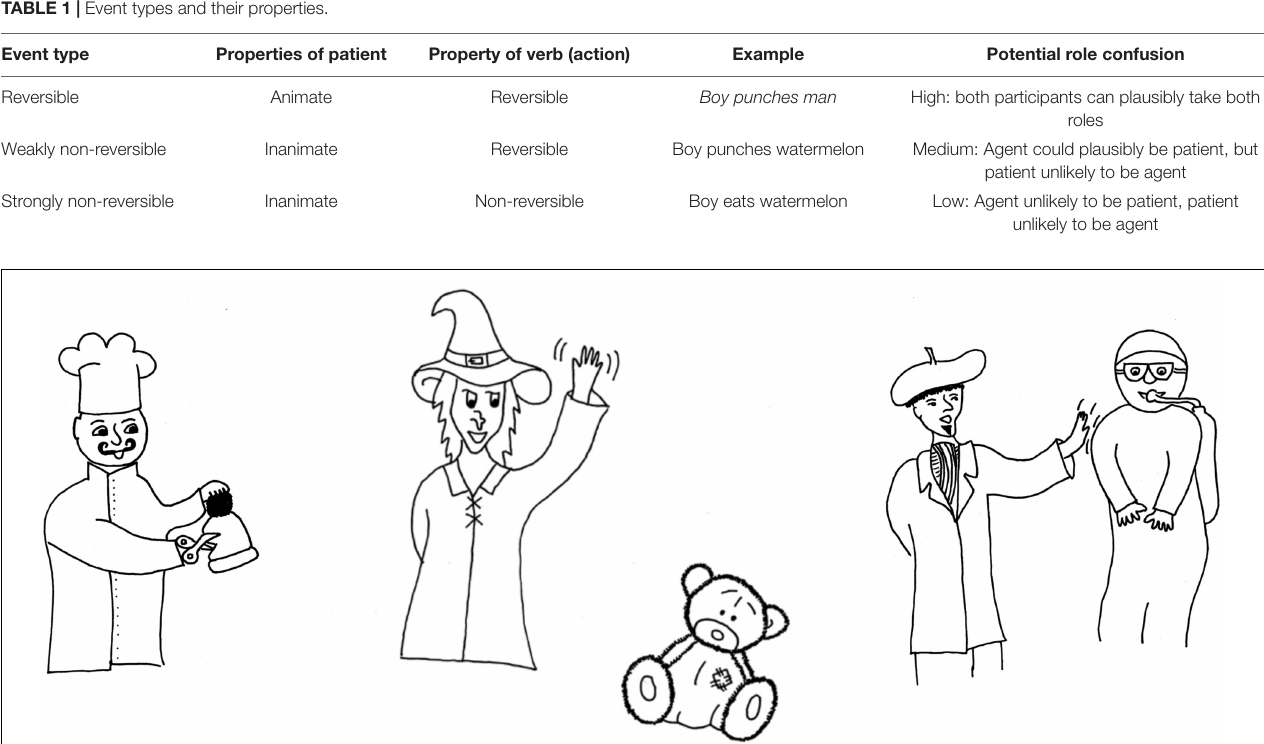
TABLE 1 | Event types and their properties.